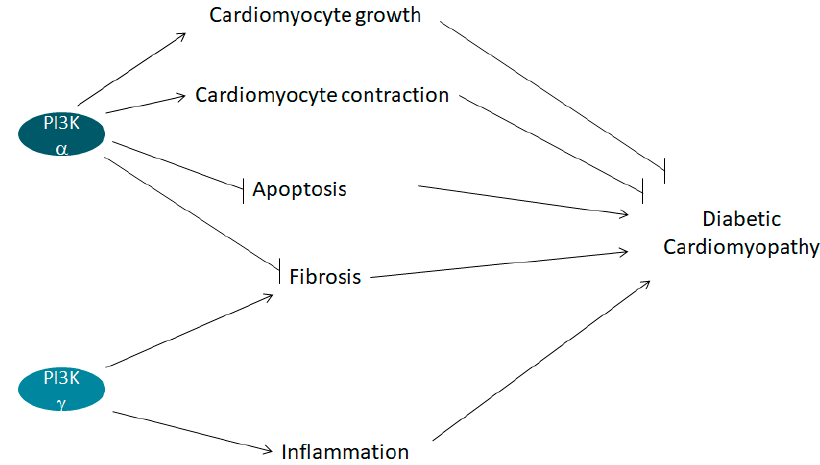
Figure 2. Main effects of PI3Ks on glucose homeostasis in muscle and liver cells. IR, Insulin Receptor. IRS, Insulin Receptor Substrate. ATP, Adenosine Triphosphate. AMPK, Adenosine Monophosphate Kinase. Activation, Figure 3. Factors by which PI3Ks affect diabetic cardiomyopathy. Activation, Inhibition. Figure 3. Factors by which PI3Ks affect diabetic cardiomyopathy. → Activation,